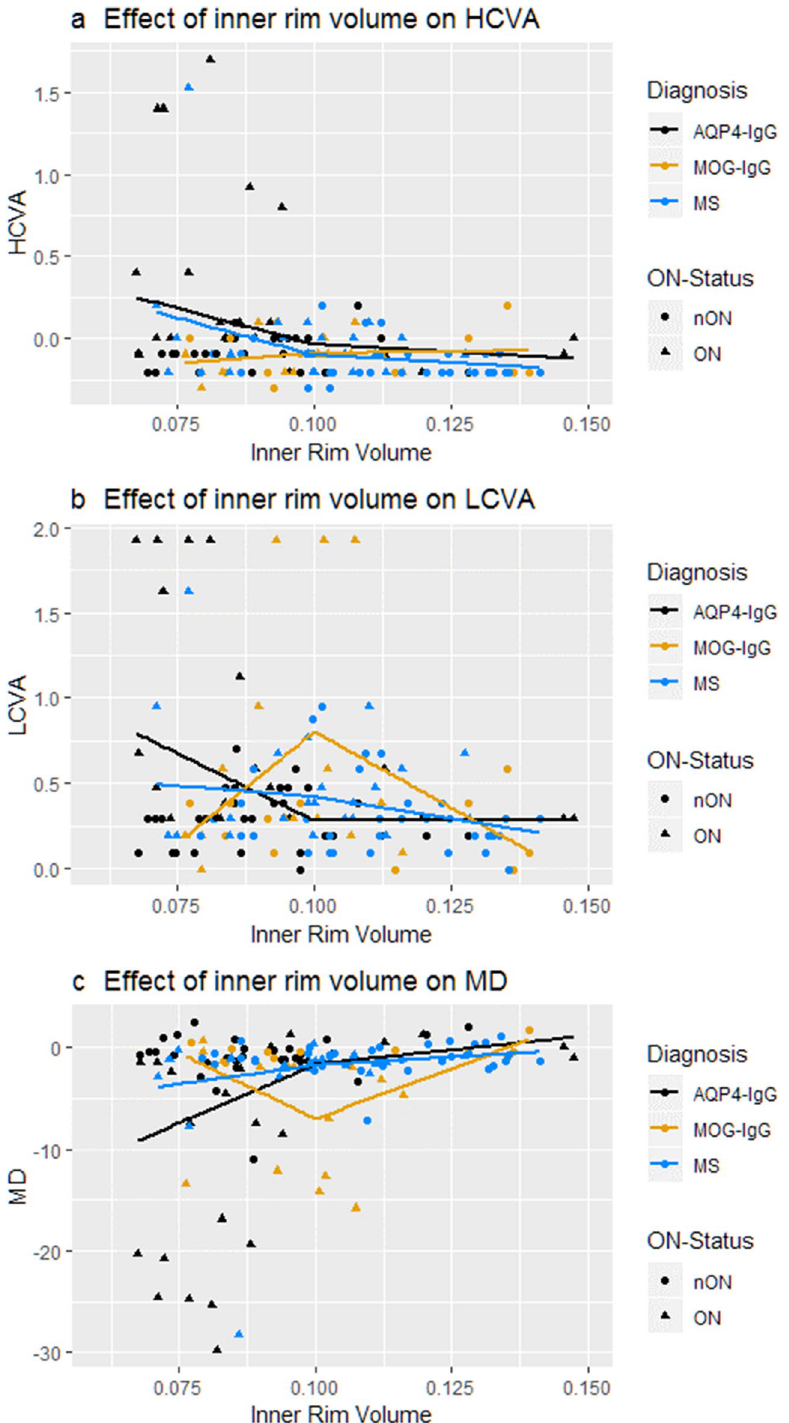
Figure 3. Association between visual function and foveal inner rim volume. Effect of inner rim volume on ( a ) high contrast visual acuity, ( b ) low contrast visual as well as ( c ) mean deviation of visual fields of patients` eyes. Cutoff for mixed linear spline model was visually identified at 0.1 mm 3 . AQP4-IgG: Aquaporin-4-IgG seropositive patients; MOG-IgG: Myelin-Oligodendrocyte-Glycoprotein-IgG seropositive patients; MS: Multiple Sclerosis patients; HCVA: High contrast visual acuity; LCVA: Low contrast visual acuity; MD: mean